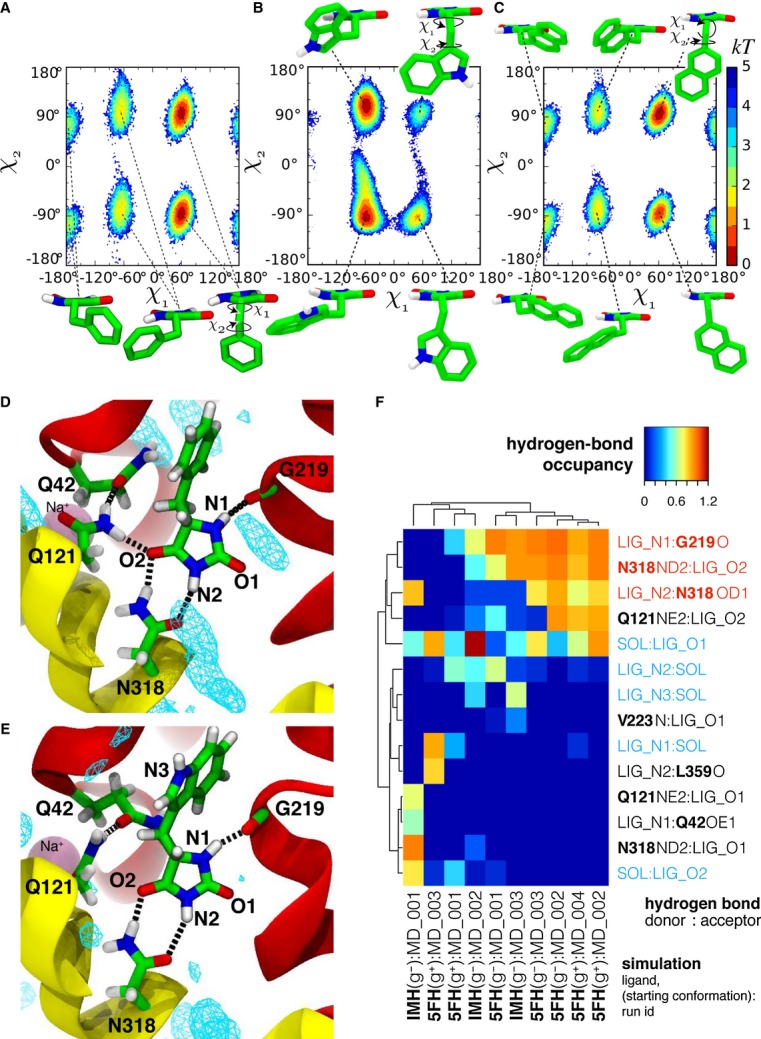
Molecular dynamics simulations of Mhp1 and its ligandsA–C Molecular conformations and conformational free energy landscape of L-BH, L-IMH and L-NMH in aqueous solution suggested by molecular dynamics simulations L-BH (A), L-IMH (B) and L-NMH (C) in solution: The conformation of the hydantoin derivatives are described by the dihedral angles χ1 and χ2 as indicated in the insets. The most probable conformations are indicated by the minima in the free energy of the system (in kT) as a function of the dihedral angles. Regions not sampled by the equilibrium simulations are white; other possible minima would be separated by barriers larger than 6 kT from the accessible regions.D–F Hydrogen bonds between substrates and Mhp1 as seen in MD simulations. The ligand and important residues are shown as sticks with hydrogen bonds as broken black lines. Helices TM1 and TM6 from the bundle are in red and TM3 and TM8 from the hash motif in yellow (parts of TM3 were removed for clarity); a sodium ion in the Na2 site is visible in the background. Water density is shown as a cyan mesh, contoured at 1.5 times the bulk value. Equivalent atoms on the ligands are labelled. (D) L-BH [from simulation 5FH(g+)MD_002]. (E) L-IMH [from simulation IMH(g–)MD_002]. (F) Clustered fingerprint analysis of hydrogen bonds. The occupancy (average number of hydrogen bonds between ligand atoms and protein or solvent atoms) from all MD simulations was clustered to show the most commonly occurring hydrogen bonding patterns. Rows describe individual hydrogen bonds (identified by donor and acceptor heavy atom) while columns label individual simulations; hydrogen bonds labelled in red were also seen in the crystal structures and in docking while blue ones indicate bonds to water molecules present in the simulation. The ligand is denoted in the simulation name as either 5FH (L-BH) or IMH (L-IMH) together with the starting conformation of the χ1 dihedral angle and the simulation number within the set. Chemically equivalent ligand atoms are treated as the same in the analysis (indicated by the generic label “LIG” instead of “5FH” or “IMH”). Hydrogen-bonded water molecules are also treated as chemically equivalent (“SOL” for solvent).